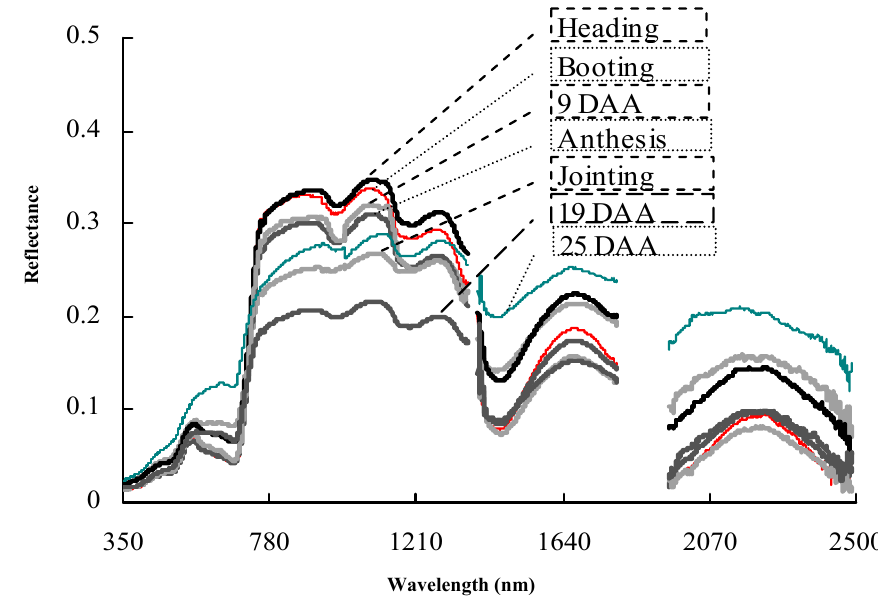
Figure 1. Dynamic changes of canopy spectral reflectance of wheat variety Ningmai 9 at different growth stages. Note: (1) DAA represents days after anthesis (2) This result was obtained under conditions applying 90 kg · ha − 1 of pure nitrogen content fertiliser with a dressing ratio of 1:1 (3) measurements were carried out at 12:00 in the growth stage on sunny days without wind and cloud.